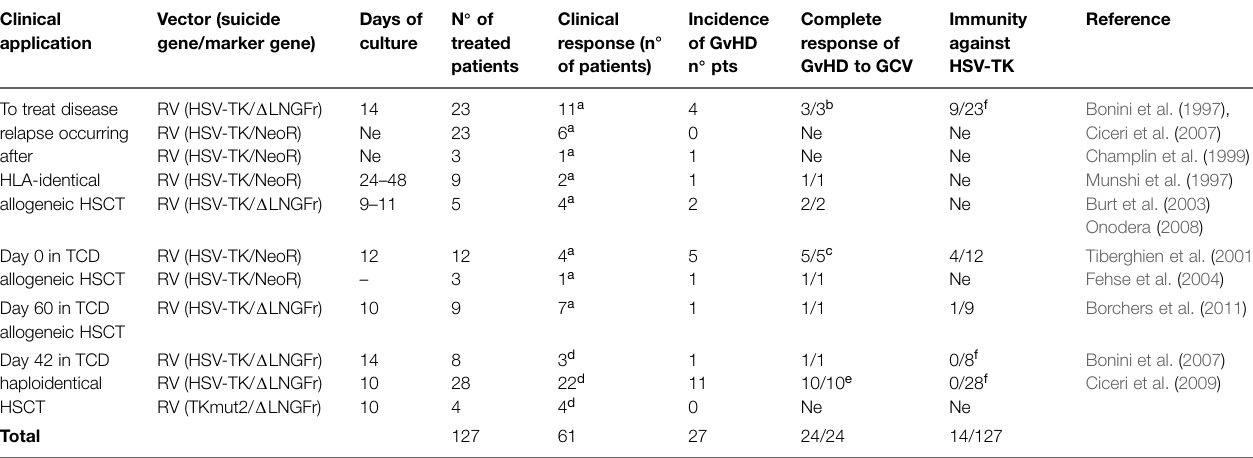
as clinical response of the malignant disease. b One patient with GvHD achieved complete response (CR) after GCV administration and immunosuppressive drugs. c One patient with GvHD achieved CR after administration of GCV and steroids. d Clinical outcome is measured in terms of T-cell immune reconstitution (evaluated as more than 100 circulating CD3 + T lymphocytes/ μ l). e Four patient with GvHD achieved CR after administration of GCV and short course low dose steroids, two patients with GvHD achieved CR after GCV administration and immunosuppressive drugs. f Immunity against HSV-TK was monitored by the appearance of TK–specific CD8 +